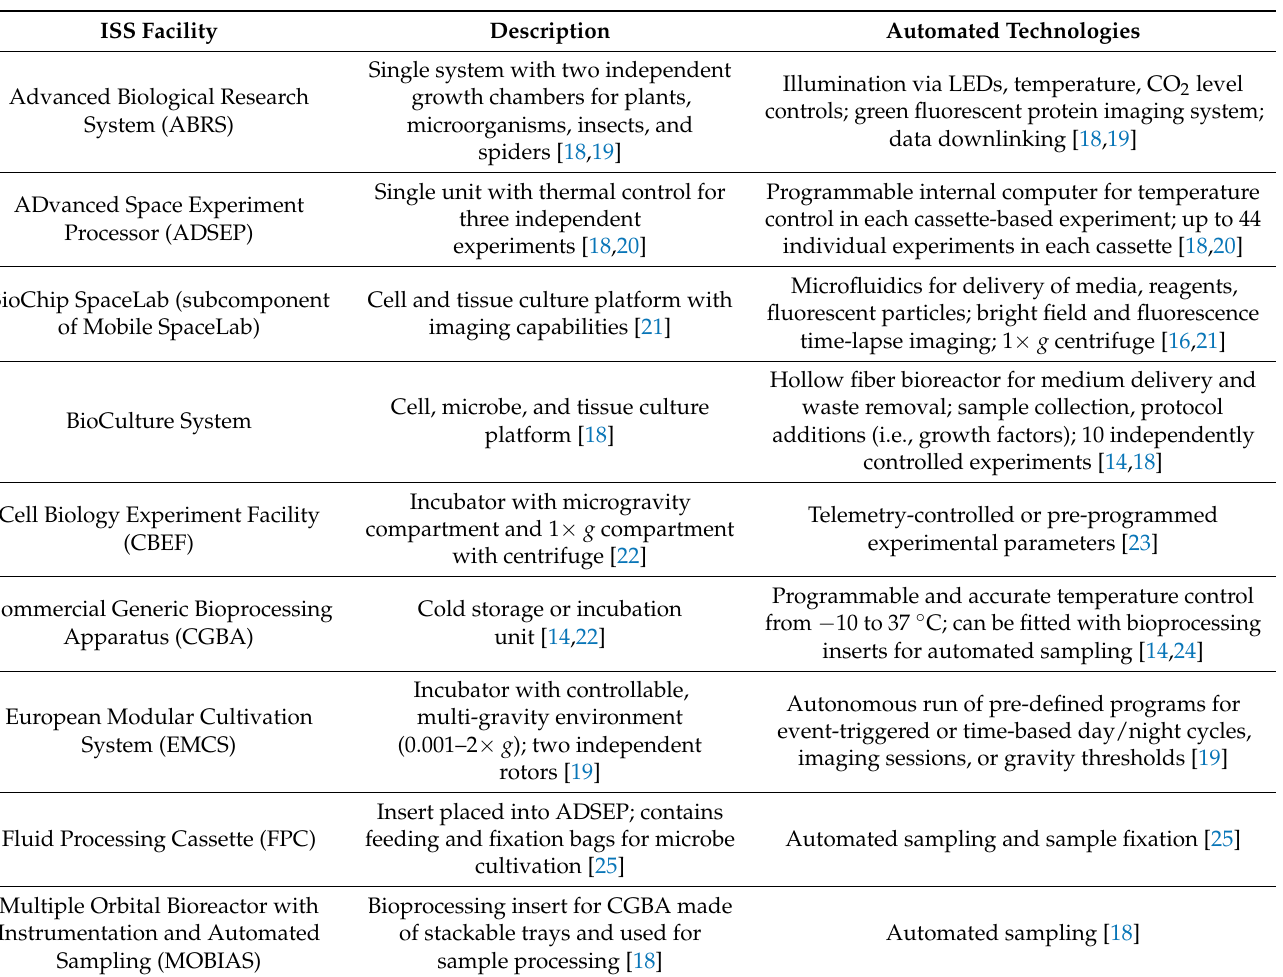
Table 1. Examples of International Space Station (ISS) facilities employing automated technologies for biological experi-